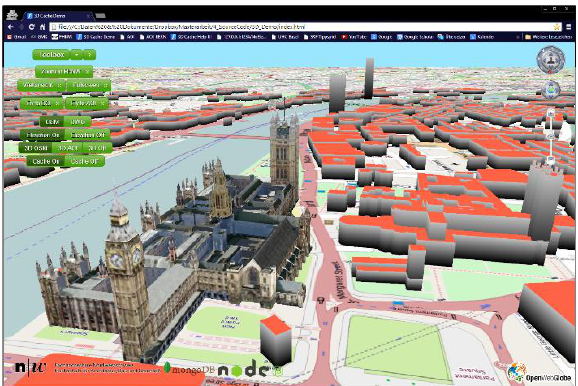
Figure 10: OpenStreetMap 3D data in the virtual globe combined with higher detailed buildings of